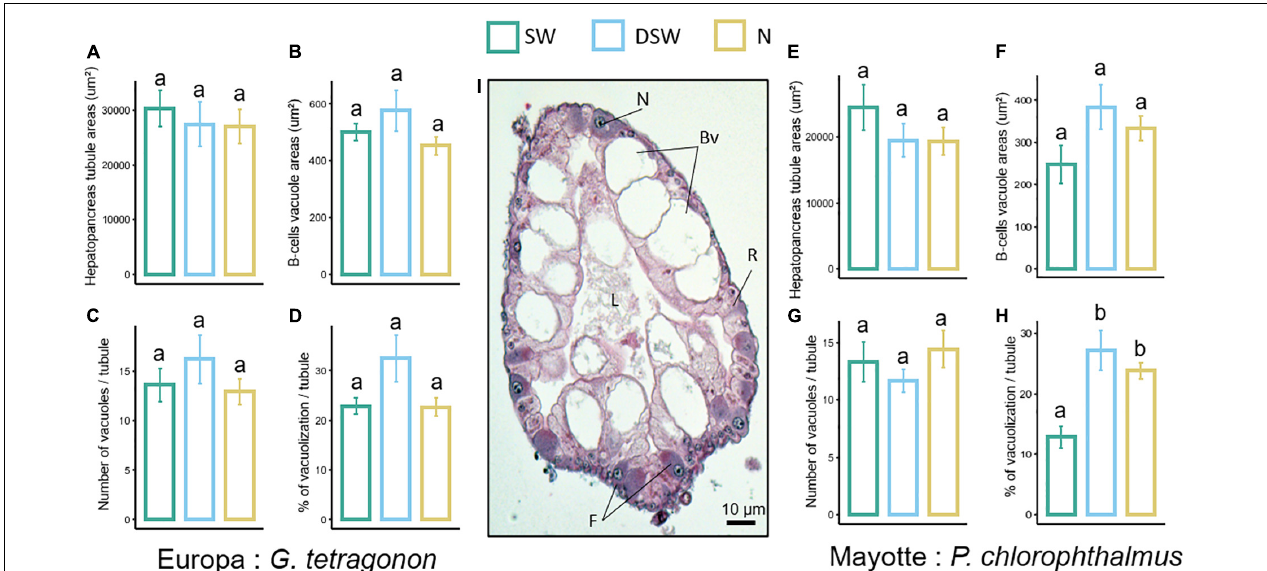
FIGURE 5 | Histological analyses from transverse sections of different tubules of GT (A–D) and PC (E–H) hepatopancreas exposed to seawater (SW), diluted seawater (DSW) and 10 mg.L - 1 ammonia-N (N). Measurements and counts were carried out on randomly distributed tubules per individual. Data were averaged per individual. (A,E) Areas of the tubules expressed as mean per individual; (B,F) B-cell vacuole areas expressed as mean per tubule per individual; (C,G) number of B-cell vacuoles in the tubule; (D,H) percentage of B-cell vacuolization area per tubule; (I) light microscopy illustration of a tubule cross section (GT). The photograph shows a tubule epithelium containing absorbing R-cells (R), enzyme synthetizing F-cells (F), and tubule-clearing B-cells (Bv). L, lumen; N, nucleus. Values are means ± SEM ( N = 3–8 per treatment). Different letters represent statistically significant differences between treatments at p < 0.05 after Wald Chi-square test and multiple comparisons